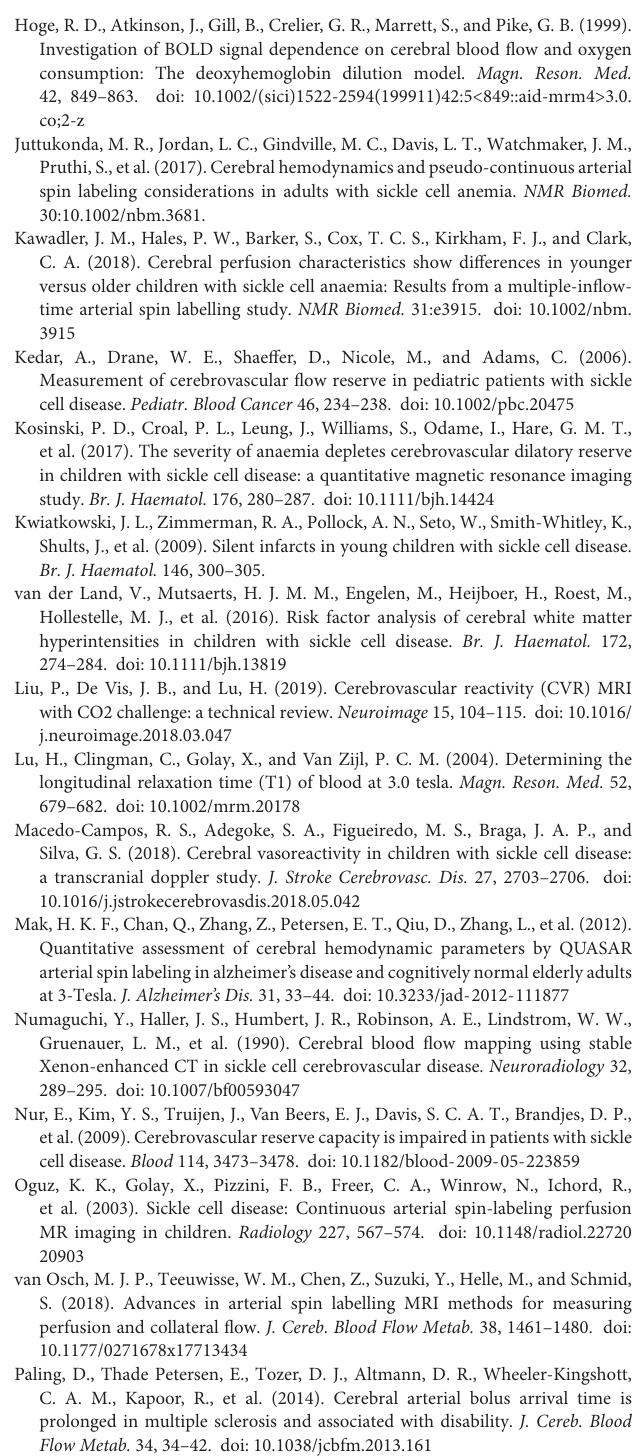
Supplementary Table 4 | Demographic information (mean ± std) and hemodynamic parameters (median [IQ range]) of mild SCD patients only, divided by treatment group. Statistically significant p values are underlined and shown in